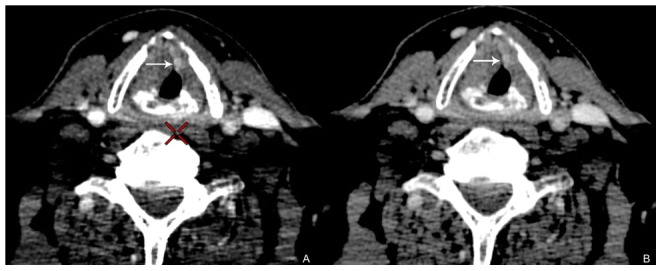
Transverse (A) monochromatic image at 55-keV energy level and (B) polychromatic images with the same window width/level obtained from spectral CT acquisition (section thickness, 0.625 mm) in 57-year-old man with glottic laryngeal SCC.The edge of the primary lesion is more clearly displayed and the image contrast is better on 55-keV monochromatic image than the polychromatic image with acceptable image noise through visual observation (arrow).